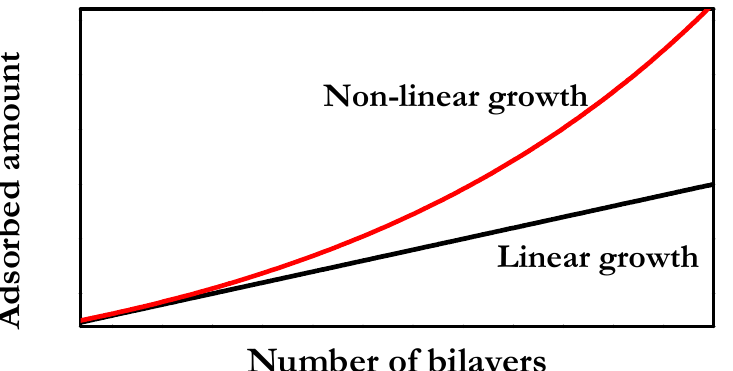
Figure 6. Idealized representation of the dependences of the adsorbed amount on the number of bilayers for LbL polyelectrolyte multilayers undergoing linear and non ‐ linear growth. Reprinted from Mateos ‐ Maroto et al. [42], with permission under Open access CC BY 4.0 license, https://crea ‐